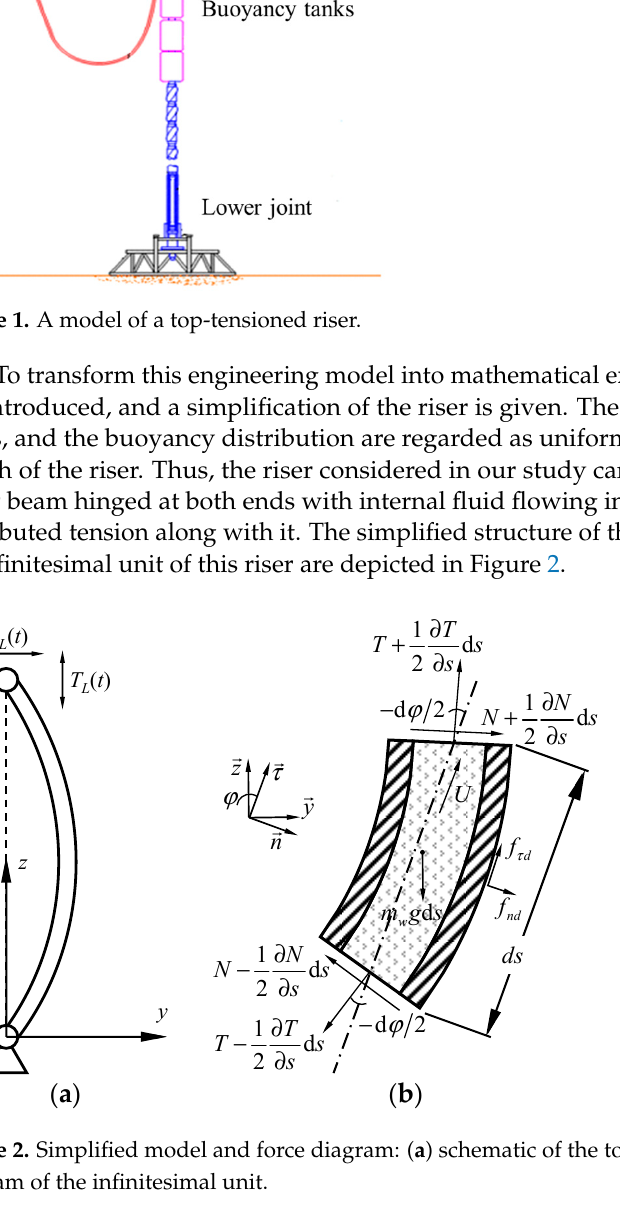
Figure 2. Simplified model and force diagram: ( a ) schematic of the top-tensioned riser and ( b ) force diagram of the infinitesimal unit.